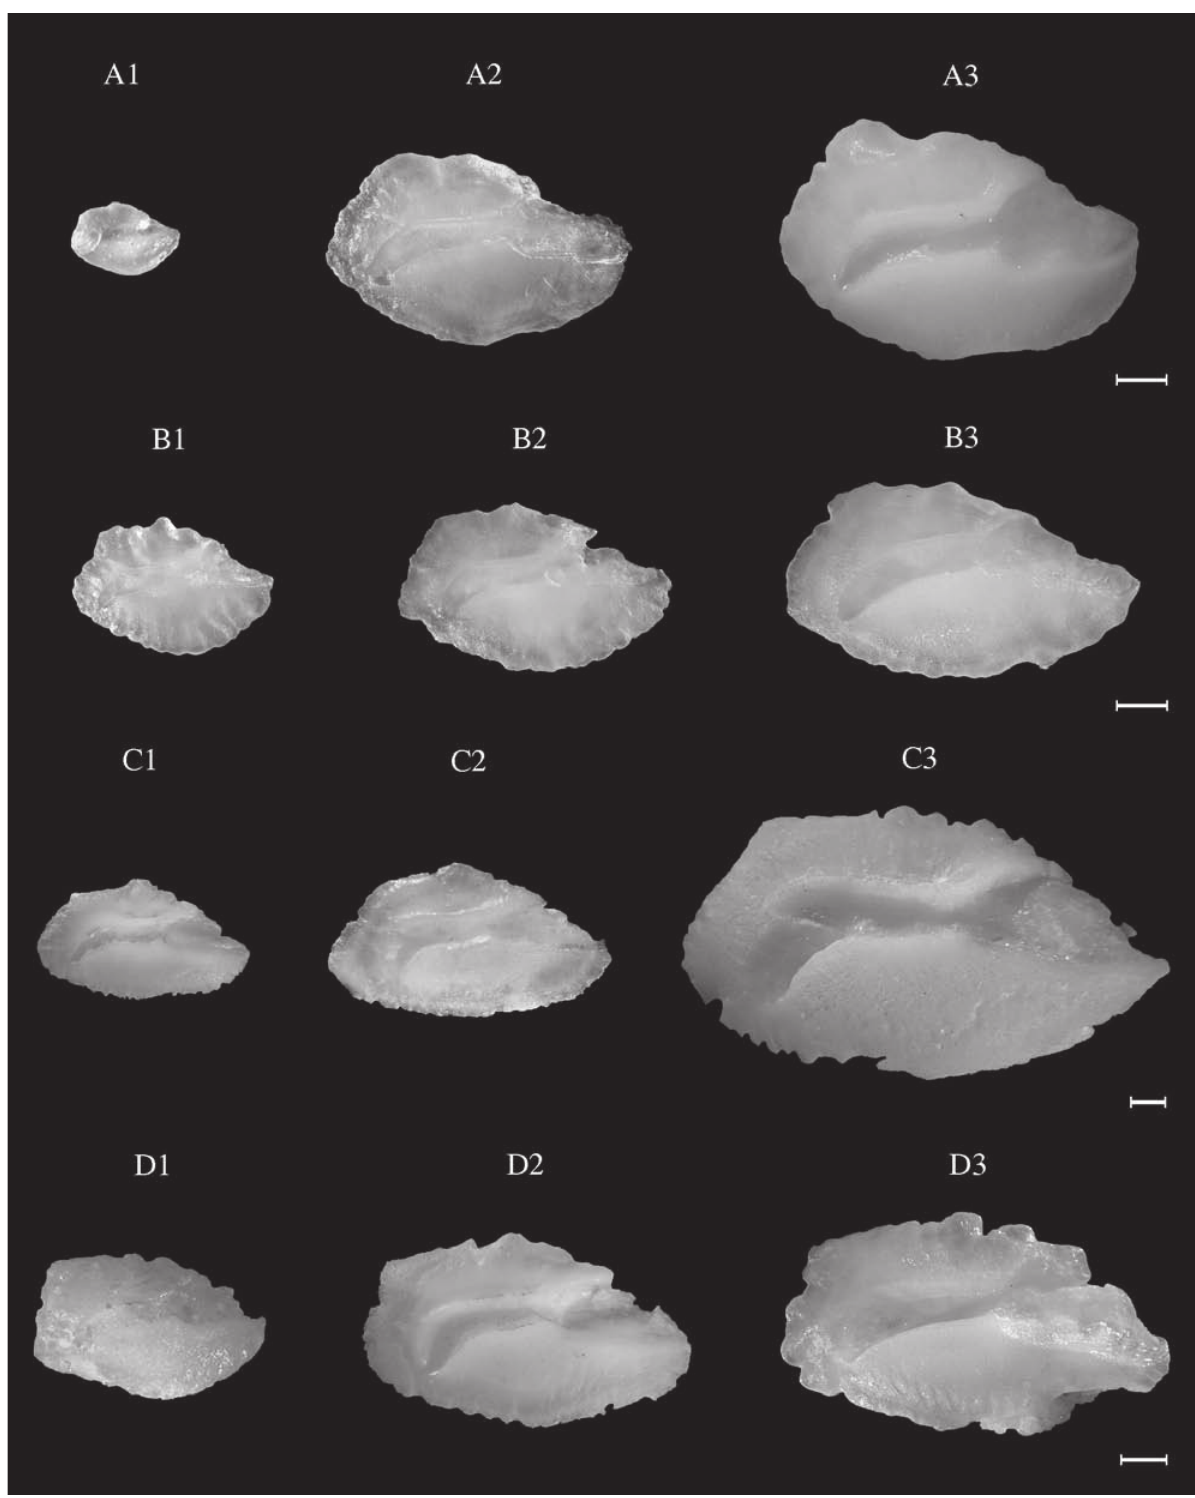
Fig. 58. – Diplodus annularis . TL: A1, 5.5 cm (WM); A2, 14.7 cm (NEA); A3, 20,0 cm (CEA). Diplodus bellottii (NEA). TL: B1, 10.2 cm; B2, 14.5 cm; B3, 19.6 cm. Diplodus cervinus . TL: C1, 14.2 cm (CEA); C2, 28.0 cm (WM); C3, 50.5 cm (CEA). Diplodus puntazzo . TL: D1, 10.0 cm (WM); D2, 30.1 cm (CEA); D3, 39.7 cm (NEA). Scale bar = 1